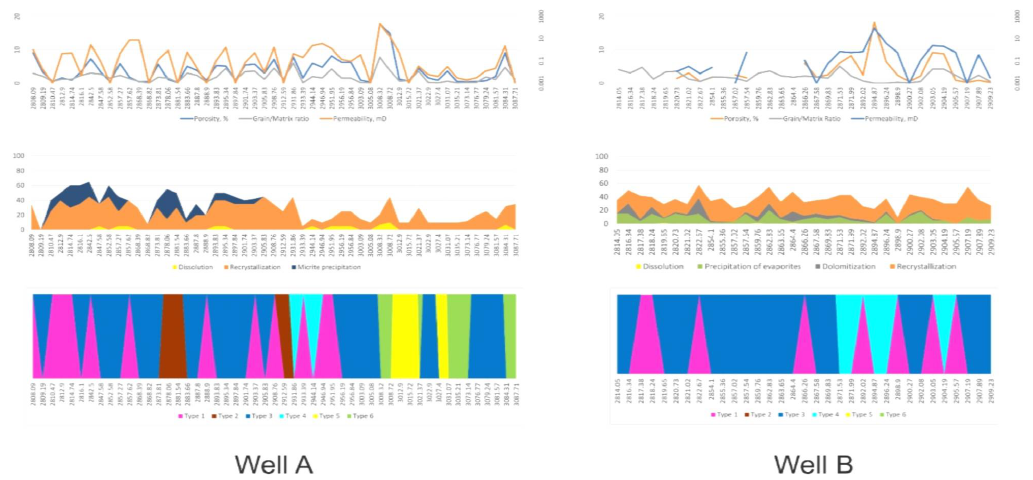
Figure 9. Stratigraphic distribution of lithotype diagenesis and reservoir properties for two wells, A and B. For well A, porosity and permeability values directly follow the changes in grain/matrix ratio, and dissolution and recrystallization emphasize the reservoir properties (e.g., at 3008.3 m). In well B, there is no visible dissolution, but dolomitization and the precipitation of evaporites occur through most of the cored interval. These diagenetic processes can either increase or reduce porosity and permeability. Both porosity and permeability are lower in the upper half of the cored interval, where evaporites are more common. Note also the increased porosity and permeability values at 2894.8 m, where the grain/matrix ratio is relatively low. It can be connected with smaller values of both evaporite precipitation and recrystallization.